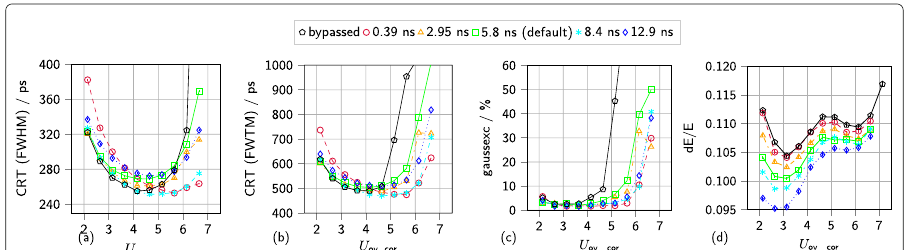
Fig. 9 Performance results dependent on the configured delay period. Data are acquired with two KETEK PA3325-WB-0808 in multi-channel coincidence experiments with vth_t1 = 50. Each SiPM array is coupled to an 8 × 8 LYSO of 12 mm height scintillator array featuring 360 μ m BaSO 4 powder mixed with epoxy as the inter-crystal layer. A geometry of five NEMA cubes ( 22 Na sources) with a total activity of approximately 3 MBq